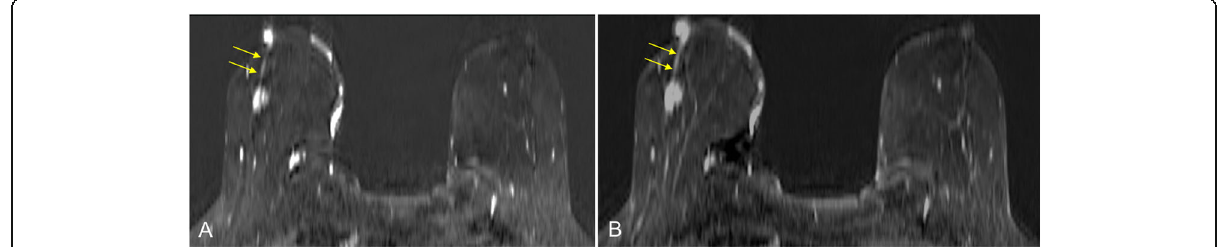
Fig. 13 Pathological enhancement in the nipple-areolar complex. A 71-year-old woman. Axial contrast-enhanced T1-weighted spoiled gradient-echo (subtracted) images show asymmetric irregular nodular early enhancement ( a ) that is maintained in late phases ( b ) secondary to involvement by invasive ductal carcinoma. Irregular-shaped masslike enhancement in the middle third of the junction of the outer quadrants in the right breast with linear uptake and segmental distribution to the nipple-areolar complex, compatible with an intraductal component (arrows)